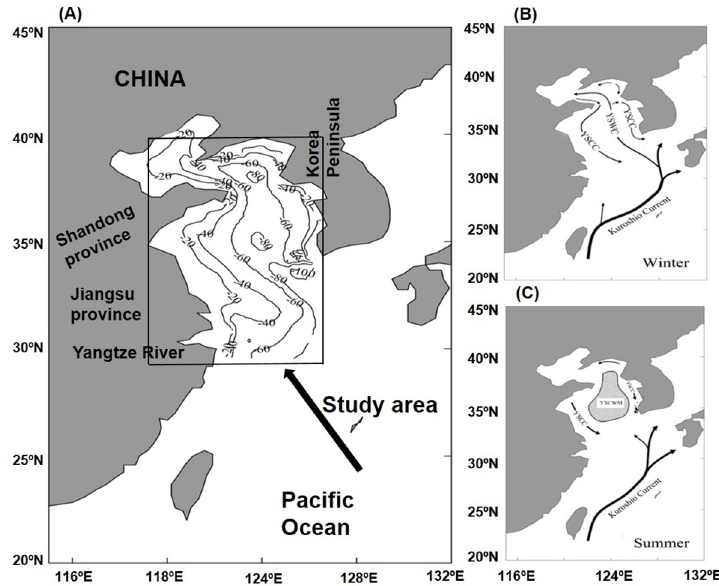
Fig 1. The study area in the Yellow Sea, China. (A) Location of the study area in the Yellow Sea. The isobaths are in meters (same in the below figures). (B) Major water currents during winter in the Yellow Sea. (C) Major water currents during summer in the Yellow Sea. Yellow Sea Coastal Current (YSCC), Yellow Sea Warm Current (YSWC), Yellow Sea Cold Water Mass